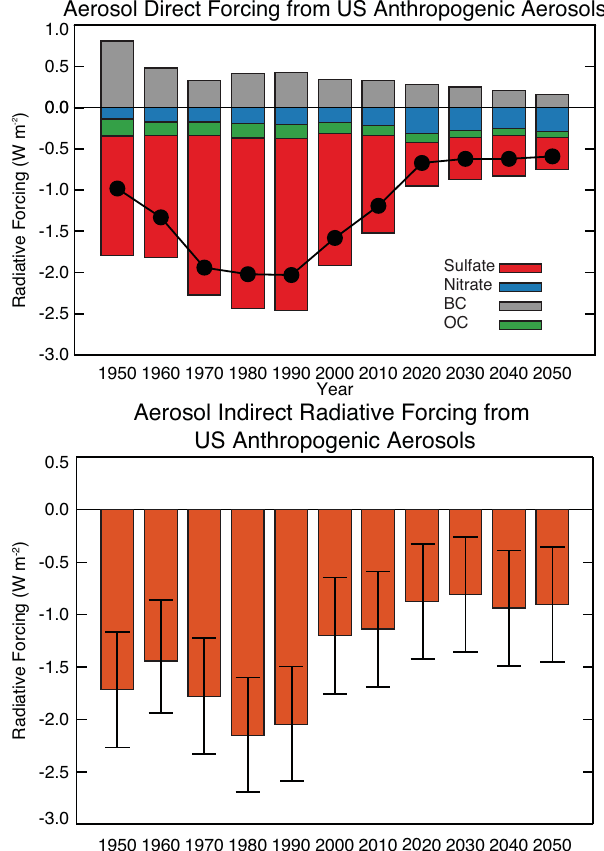
Fig. 8. 1950–2050 evolution of aerosol direct (top) and total (first + second) indirect radiative forcing (bottom) from US anthropogenic sources over the eastern US (east of 100 ◦ W). Circles represent the net direct radiative forcing and the bars give the contributions from the different components. The direct radiative forcing calculations are for an internal aerosol mixture. Aerosol indirect radiative forc- ing is calculated as the difference between two 50-yr equilibrium climate simulations with vs. without US anthropogenic aerosols. The error bars represent the 95% confidence interval of the forcing based on model interannual